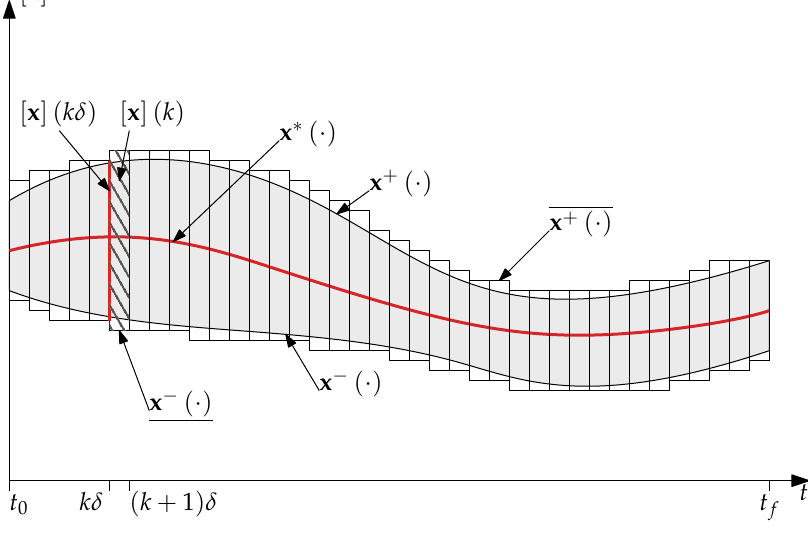
Figure 6. Implementation of a tube inside